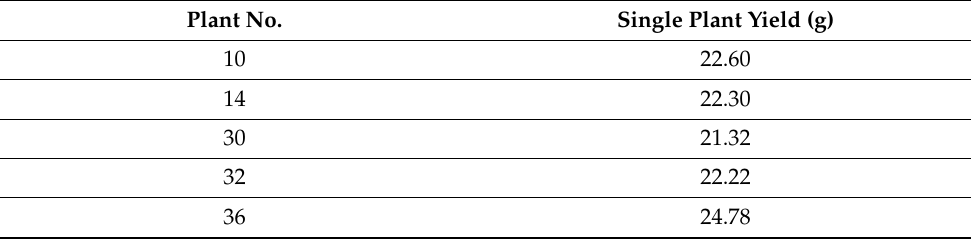
Table 1. Single plant grain yield of selected gene introgressed progenies of BC1F1 cross of CB 87 R × (CB 87 R × IRBB